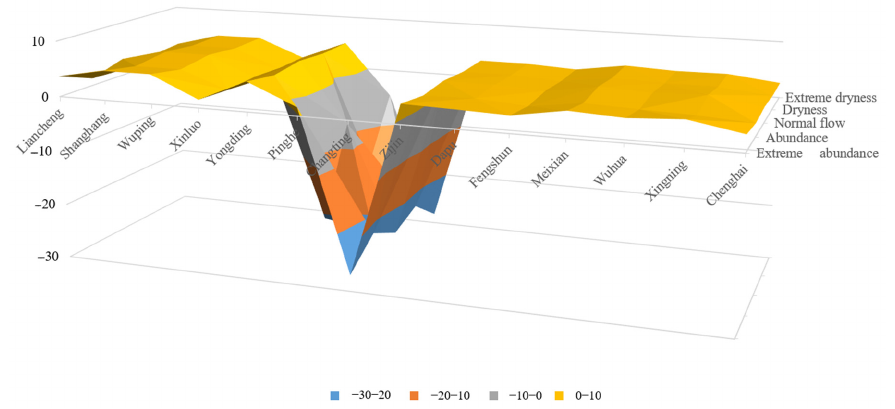
Figure 5. Difference between the lower bound of economic benefits for each administrative unit of the IFTSC and IFTS models (×10 8 CNY). the IFTSC and IFTS models ( × 10 8